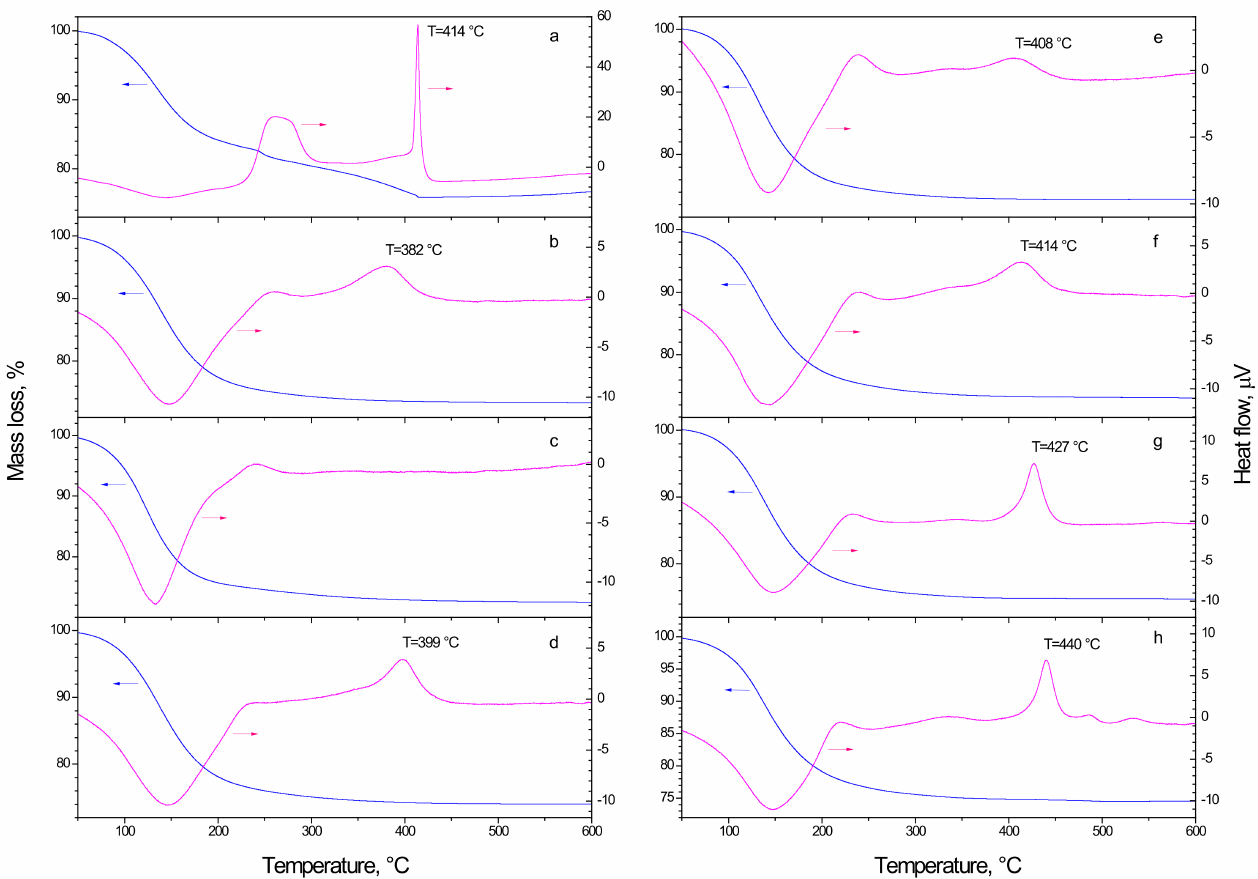
Figure 1. TGA (left axis) and DTA (right axis) measurements of as-synthetized V-TiO 2 samples with 0 ( a ), 0.5 ( b ), 1 ( c ), 2 ( d ), 5 ( e ), 7 ( f ), 10 ( g ) and 20 ( h ) mol% vanadium